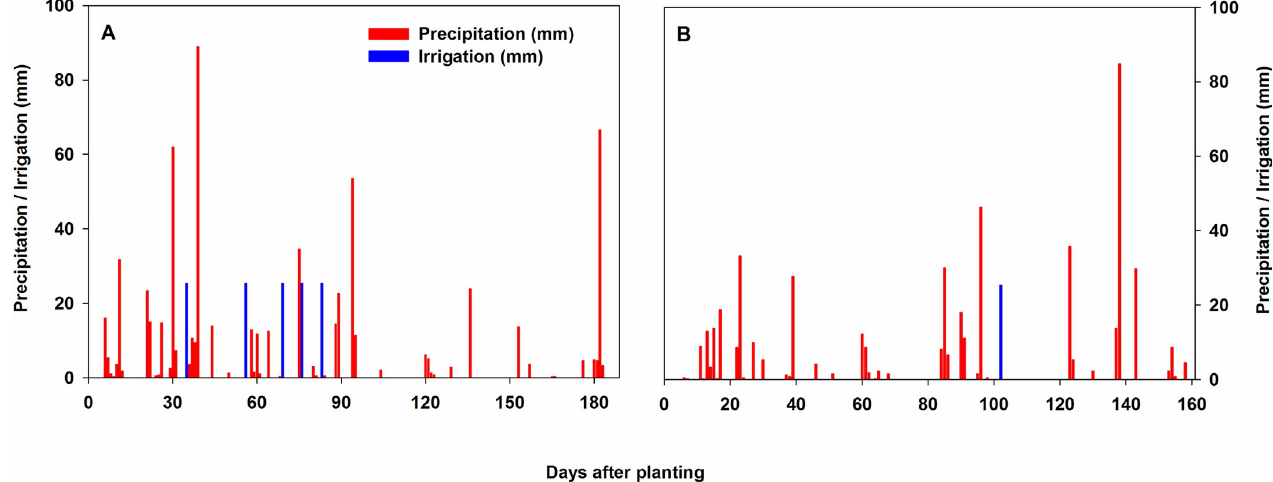
Fig 3. Daily precipitation and irrigation from planting through the end of the season at Florence, SC, USA (a) and Pendleton, SC, USA (b). Precipitation data were obtained from the National Centers for Environmental Information (NCEI) of National Oceanic and Atmospheric Administration (NOAA). Soybean genotypes were planted on 9 June 2017 at Florence and 8 June 2017 at Pendleton. The duration of the crop season was 188 and 161 d in Florence and Pendleton, respectively. Irrigation involved application of 25.4 mm water at 35, 56, 69, 76, and 83 days after planting (DAP) at Florence and application of 25.4 mm water at 102 DAP at